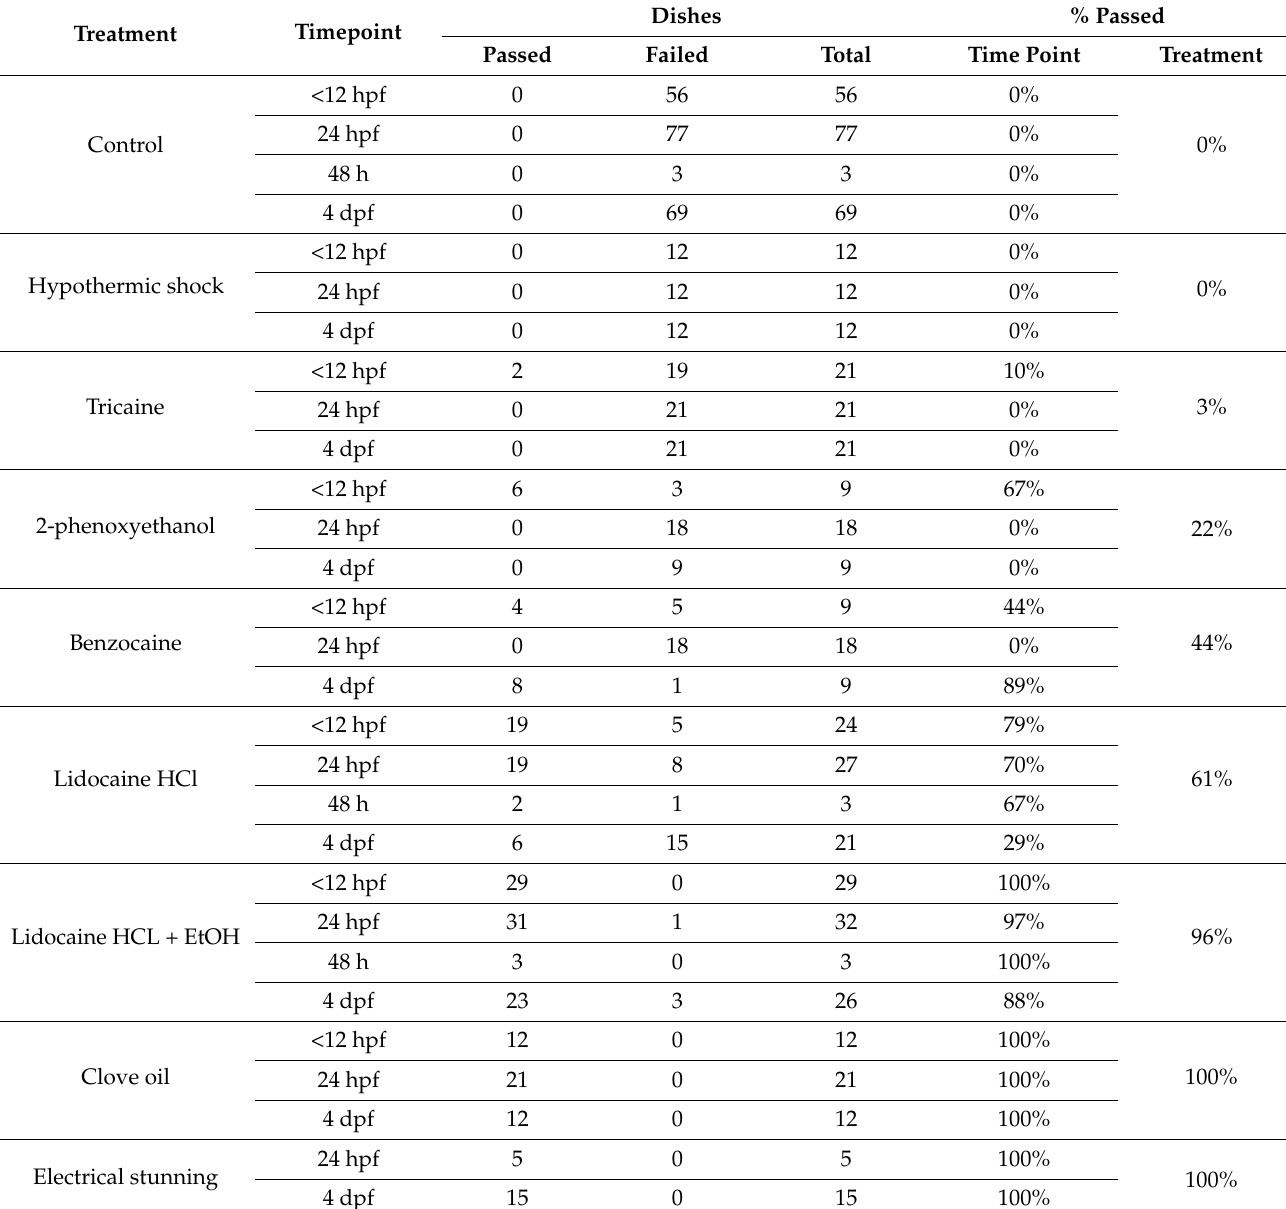
Table 4. Success of the experimental method for zebrafish embryo and larva euthanasia, results per dish. Passed; dishes had zero surviving embryos or larvae after treatment. Failed; dishes had one-or-more embryo or larva surviving treatment. hpf; hours post fertilization. dpf; days post